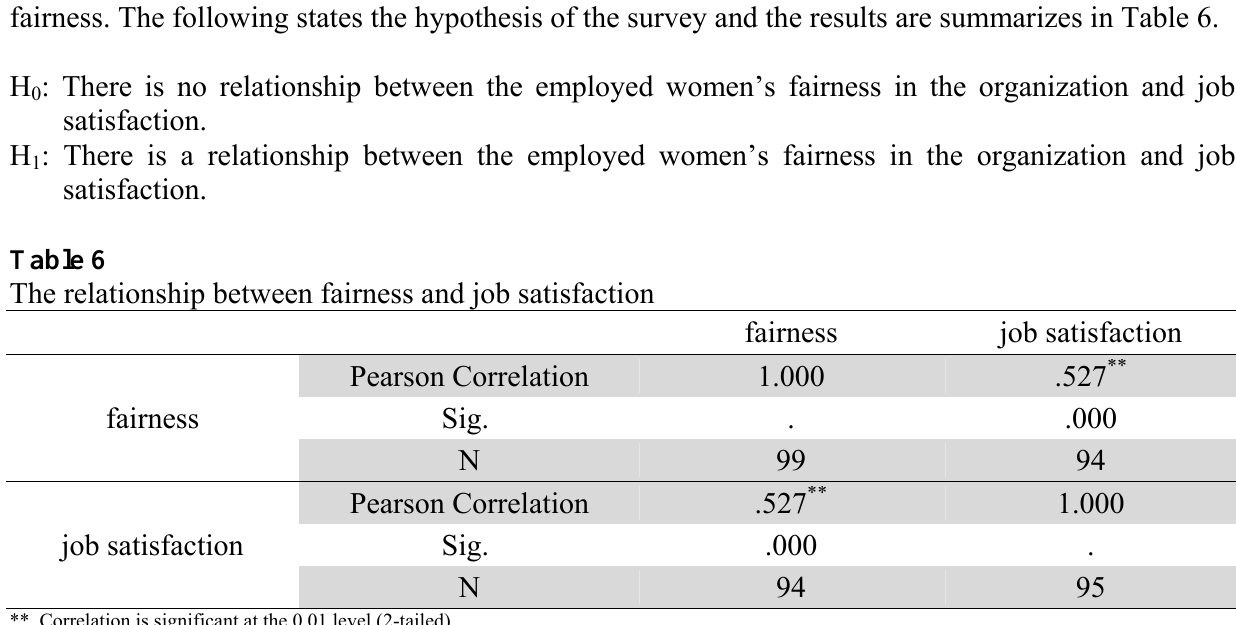
Pearson fairness